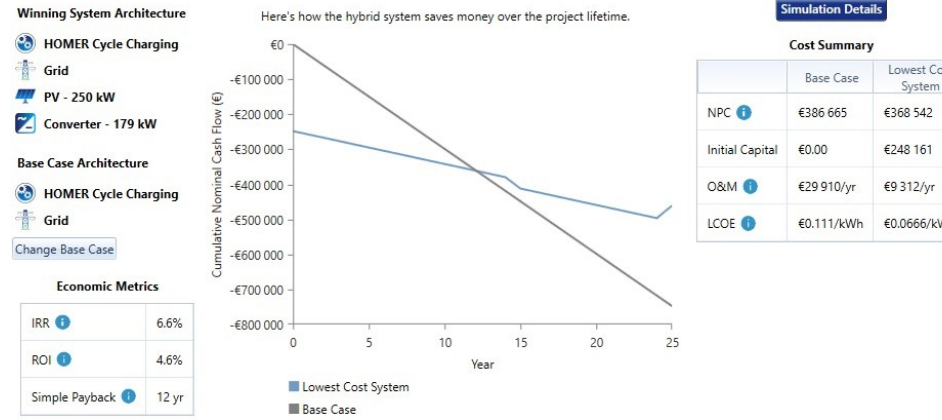
Figure 9. Selection of optimal microgrid model after evaluation.